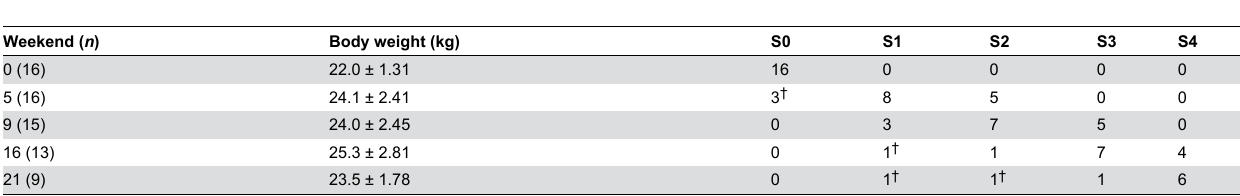
Table 1. Body weight and liver fibrosis stages of surviving miniature minipigs on the follow-up weekends.